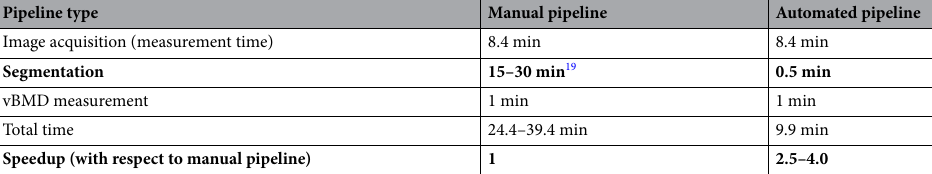
Table 2. Comparison of the gold standard manual pipeline and the automatic pipeline. Manual and automatic pipeline only differ in the segmentation step. For the manual pipeline an expert has to annotate the patient’s slices semi-automatically while for the automatic pipeline, a neural network predicts the location of the second MC. Both network variants, the 2D U-Net and the 3D U-Net have similar run times for the segmentation task. Differences of time between manual pipeline and automated pipeline are highlighted in bold